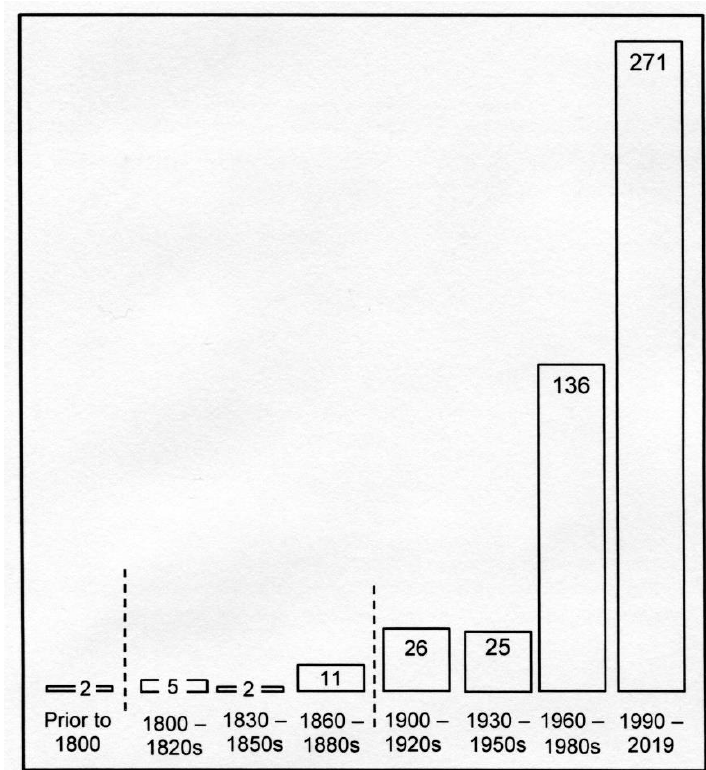
Figure 3. Number of treeline-related publications during consecutive 30-years periods, compiled from the reference list of the current article. Note the exorbitant increase since the 1960s and especially since